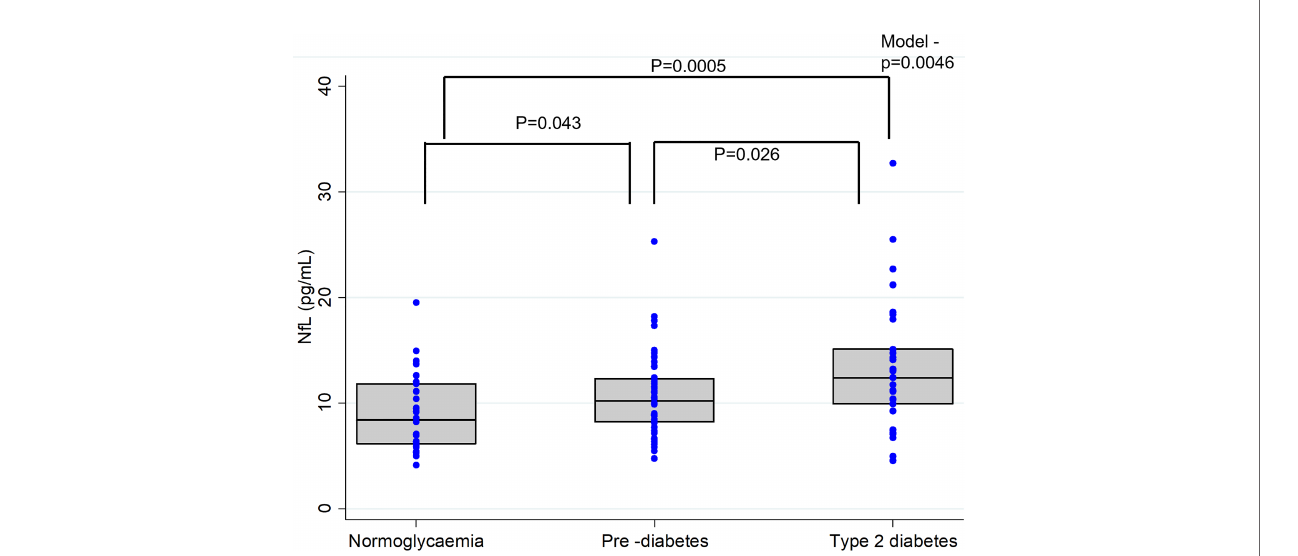
FIGURE 1 | Plasma Neuro fi lament light (NFL) concentrations in individuals with normal glucose levels, pre-diabetes and type 2 diabetes. In the box-whisker plots central bar indicate the median NFL concentration and upper and lower boundaries. Blue dots represent the NFL data points. P-values representing differences in plasma NfL levels between the groups were obtained from Post-hoc analysis (Dunn's test).